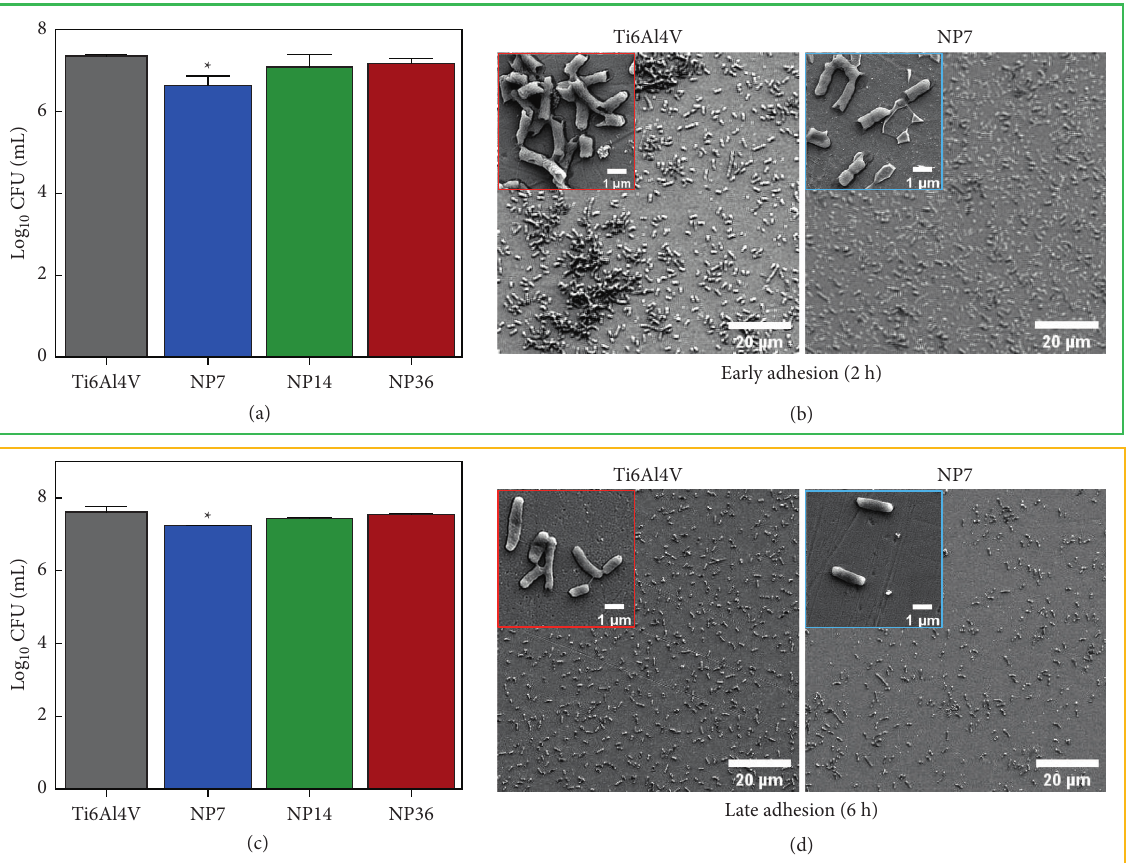
Figure 4: Antibacterial behavior of E. coli on the experimental materials. (a) Viability evaluation after 2h of incubation. (b) E. coli morphology on the control and NP7 material at early adhesion phase. (c) E. coli growing viability after 6h. (d) E. coli phenotype characterization at the late adhesion. The symbol ∗ shows significant cell viable differences between the material